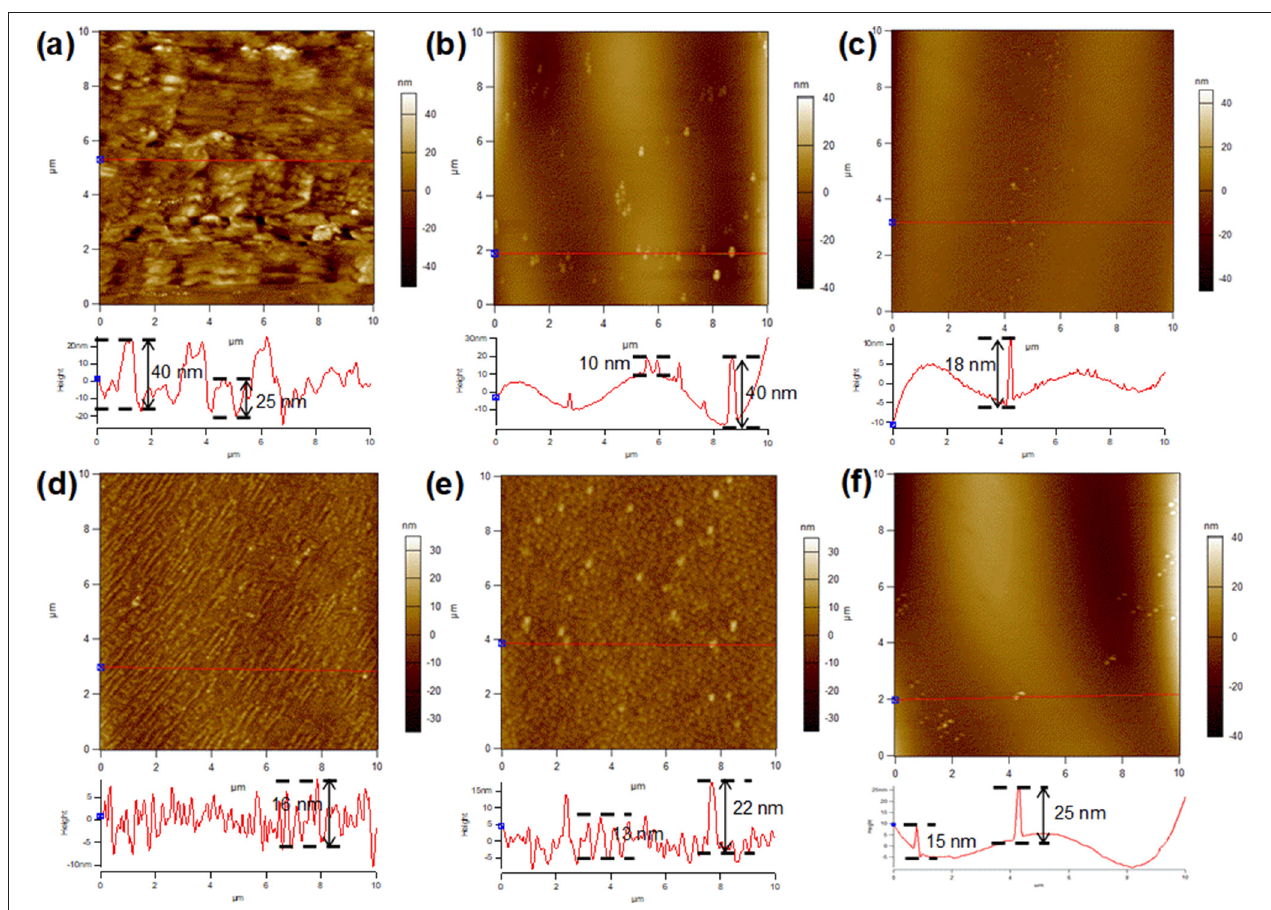
FIGURE 2 | AFM images of Cu foil with an oxide layer pretreated with different annealing times in Ar/H 2 . (a) 0, (b) 15, (c) 30, (d) 45, (e) 60, and (f)